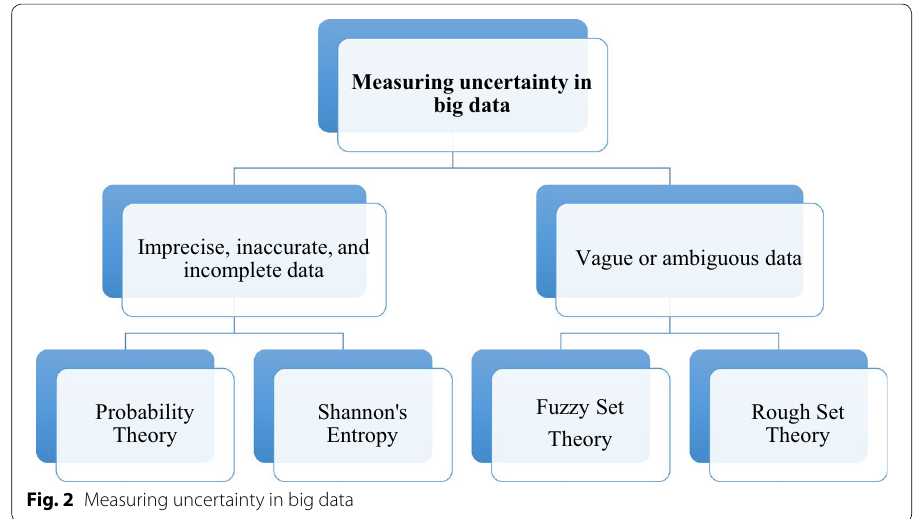
Fig. 2 Measuring uncertainty in big data